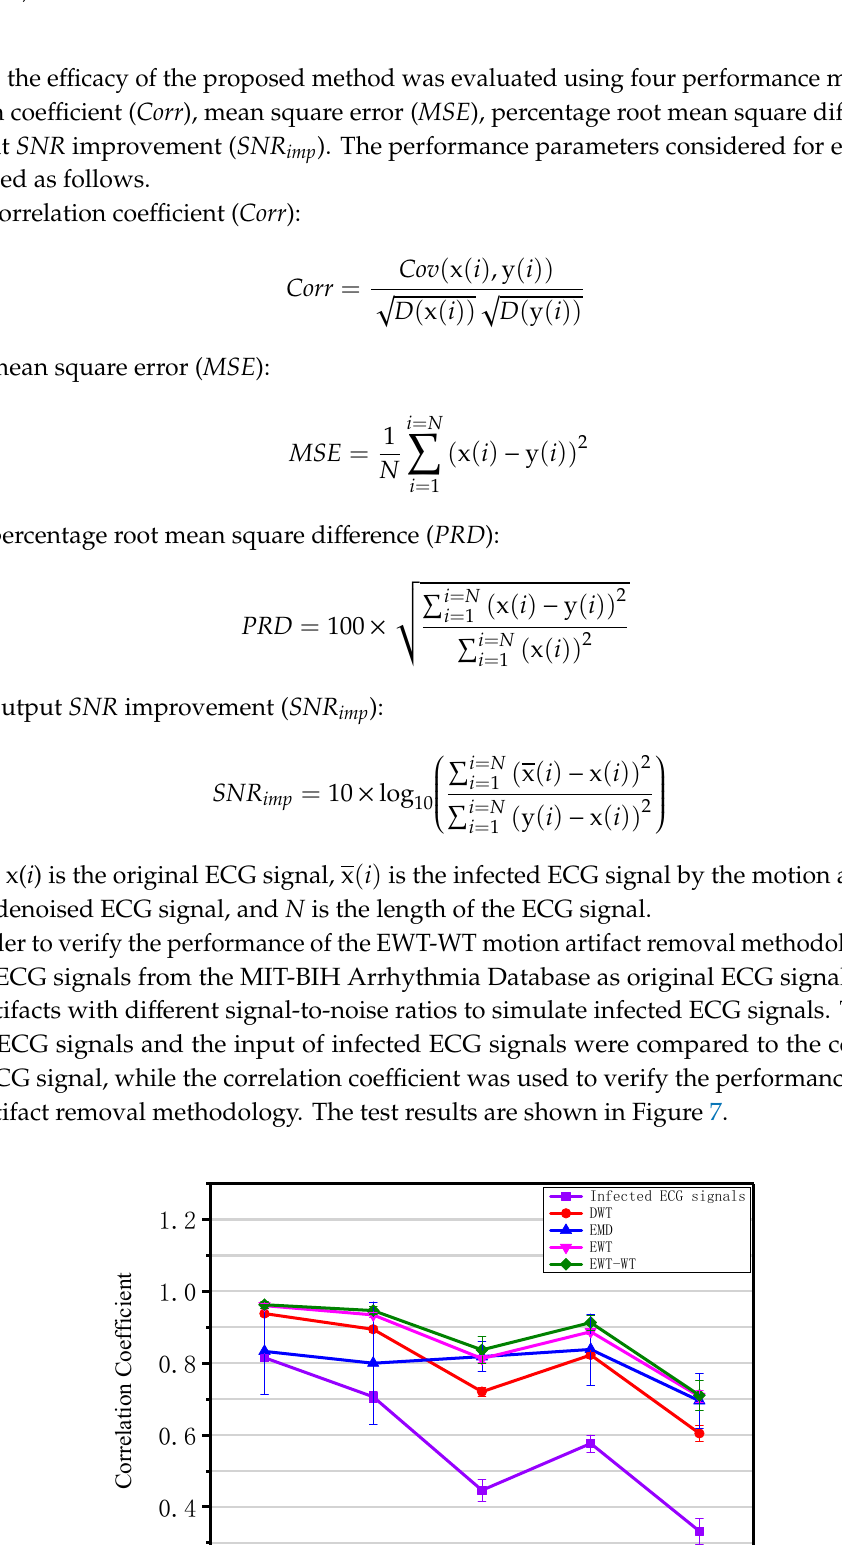
Table 1. The MSE of the output ECG signals using DWT, EMD, EWT and EWT-WT methods. Record